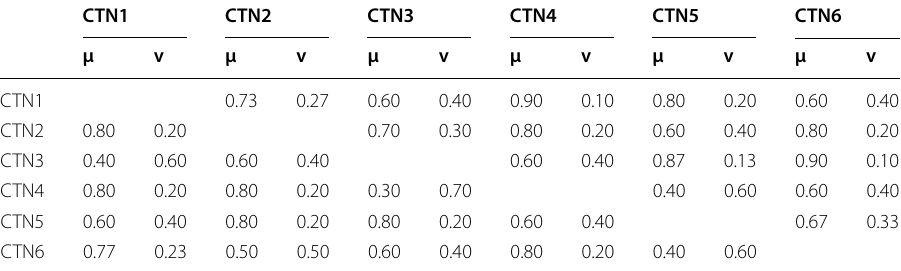
Table 4 Average values of membership and non-membership degrees for the criteria